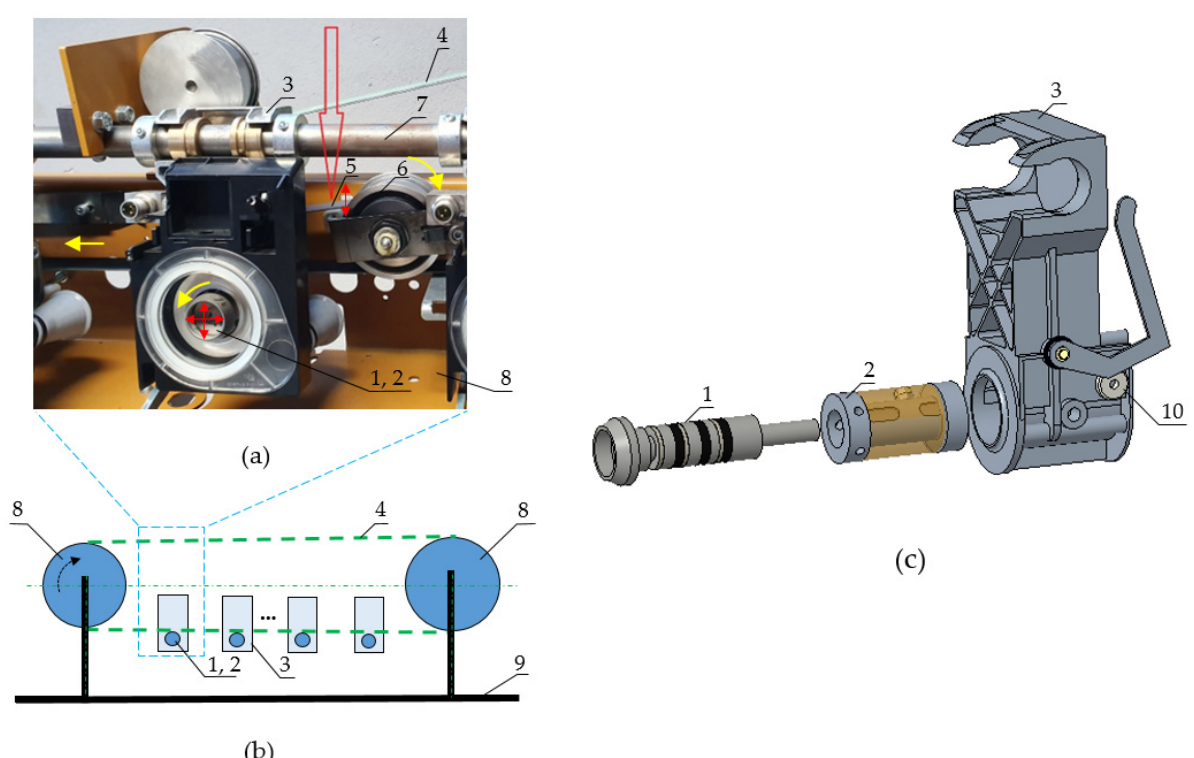
Figure 2. ( a ) Spinning unit of testing bench, ( b ) Schema of testing bench, ( c ) Decomposition of spinning unit, additional polymer composite material (transparency brown)—rotor bearing (1), rotor casing (2), housing body (3), driving belt (4), pressure plate (5), idler pulley (6), rod (7), driving and driven pulley (8), frame (9), accelerometer (10).